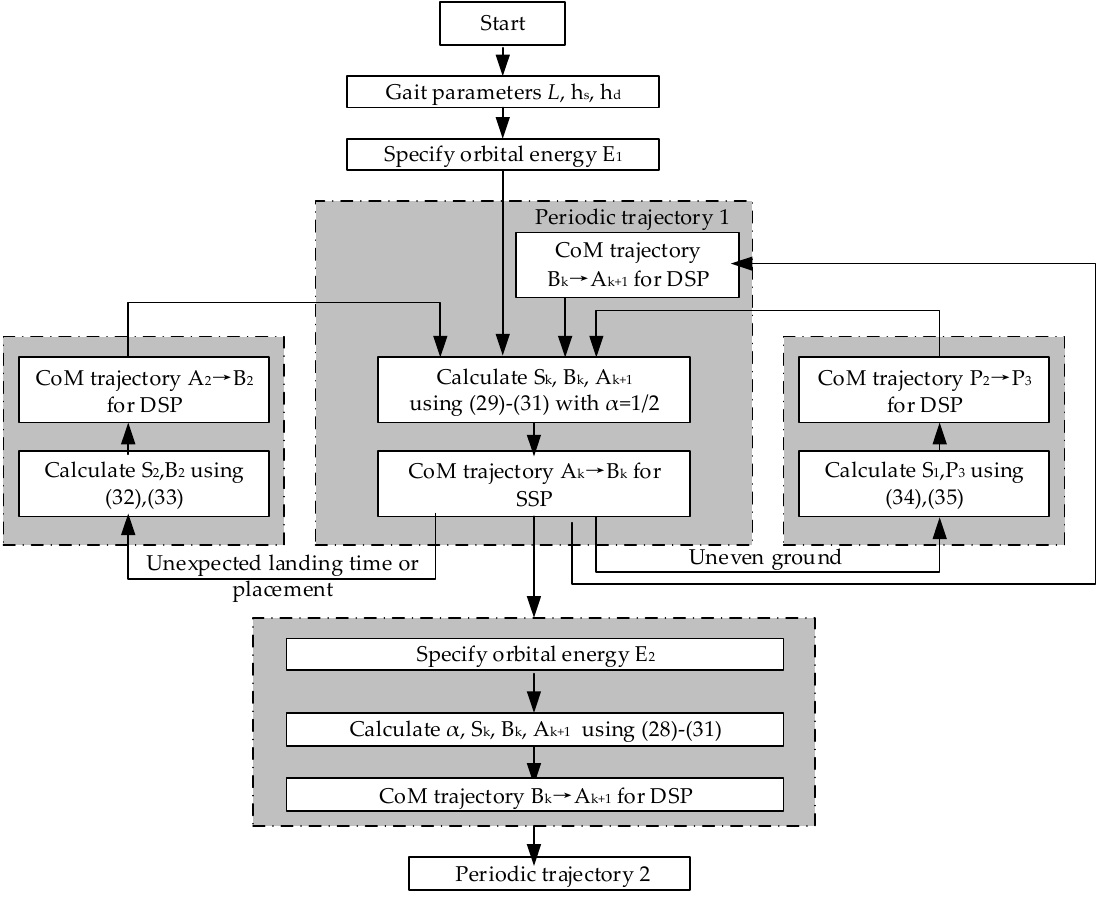
Figure 13. Flow chart of proposed methods including periodic walking, adjusting walking speed, recovery of unexpected landing, and walking on uneven ground. In the blocks of periodic walking and adjusting walking speed, A k , B k , S k and A k+1 are shown in Figure 9. In the block of unexpected landing time or placement, A 2 , B 2 and S 2 are shown in Figure 11. In the block of uneven ground, P 2 , P 3 and S 1 are shown in Figure 12.